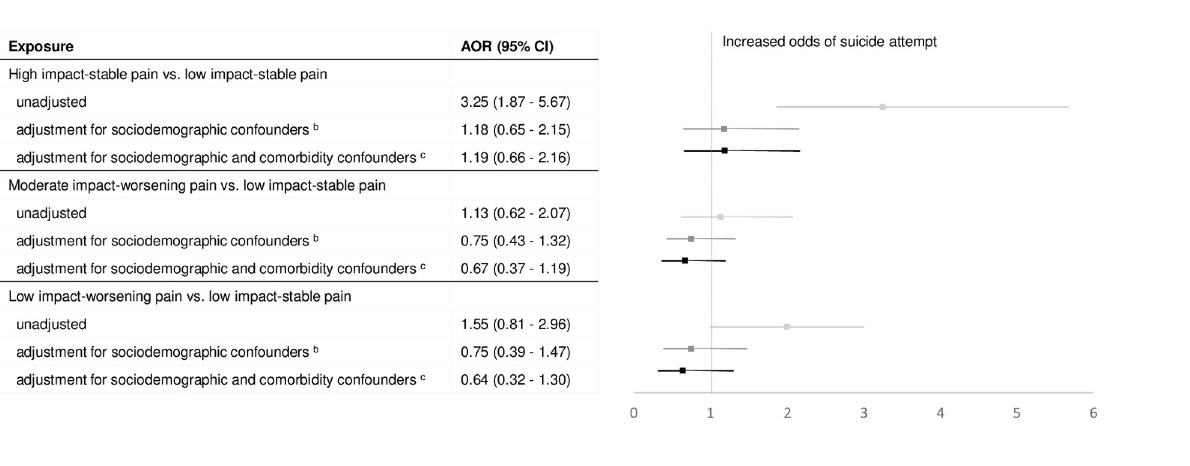
Fig 3. Effects of pain phenotypes on suicide attempt. a Forest plot with odds ratio and 95% confidence intervals of the pain phenotypes with low impact-stable pain as reference from the multinomial logistic regression models. The figure shows the effect sizes with and without weights and using the long and short set of covariates for suicide attempt. b The short set covariates includes sociodemographic characteristics (excludes comorbid health conditions) as predictors. c The long set covariates includes all covariates–sociodemographic characteristics and comorbidities.